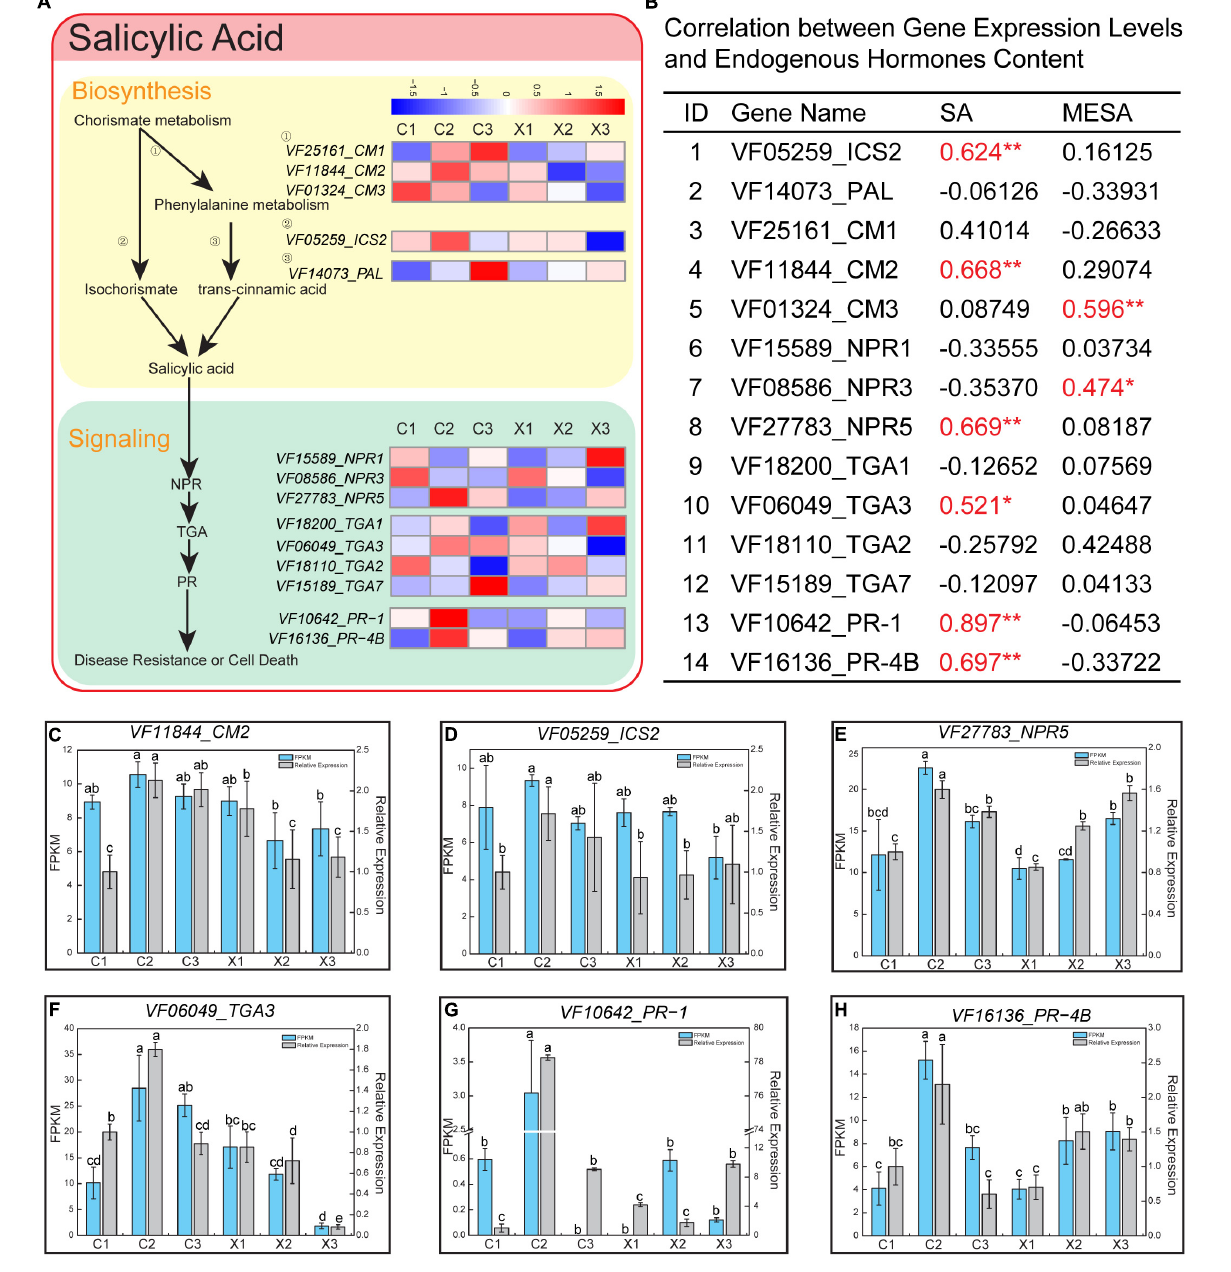
FIGURE 5 | Salicylic acid (SA) pathway in male and female flowers. (A) Representative gene expression profiles of SA biosynthesis and signaling pathway. The color intensity in the heatmap of each gene represents the relative expression levels of these genes at different stages of male and female flowers. (B) Correlation between gene expression levels and endogenous hormones content in male and female flowers. “ ∗ ” and “ ∗∗ ” after the correlation coefficients represent the correlation between their mRNA levels and endogenous hormone levels significantly different at p < 0.05 and p < 0.01, respectively. (C–H) Expression levels of CM2 , ICS2 , NPR5 , TGA3 , PR-1 , and PR-4B based on FPKM and qRT-PCR data. Error bars indicate SD. Different letters represent significant difference in mRNA levels ( p <